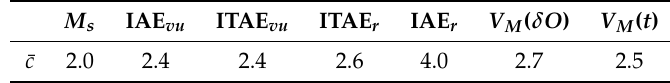
Table 3. Summary: The table shows the recommended settings for the MP parameter ¯ c for minimizing the objectives in the first